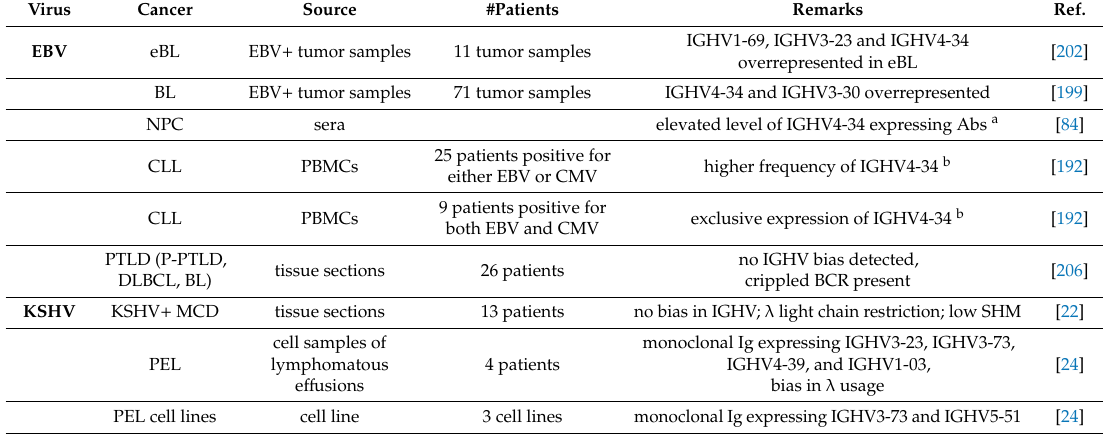
Table 2. BCR repertoire of gammaherpesvirus-associated